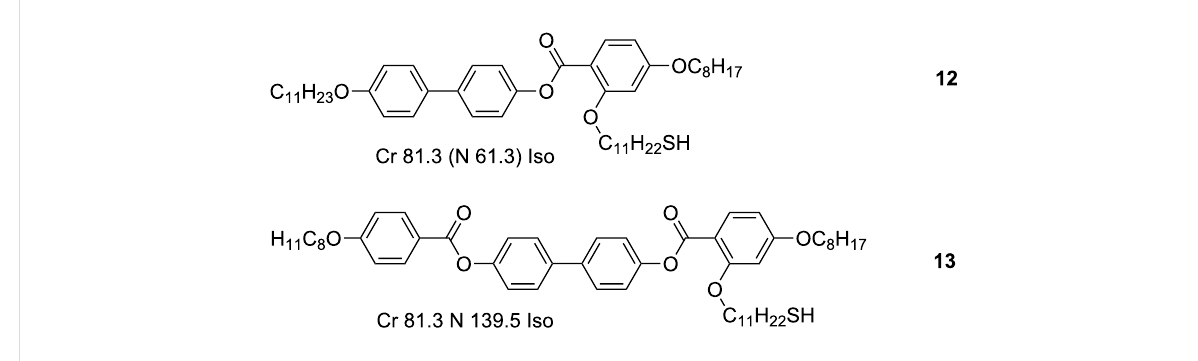
Figure 13: Chemical structures and LC properties of side-on mesogens used to coat NPs.